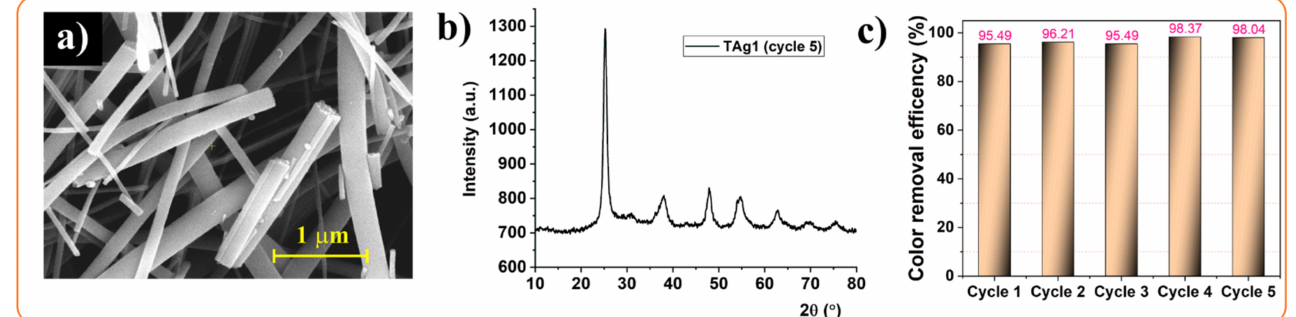
Figure 11. SEM image and XRD pattern of TAg1 reused material after five cycles ( a , b ); color removal efficiency after 60 min in the presence of both materials (TAg1 reused and pristine) ( c ).